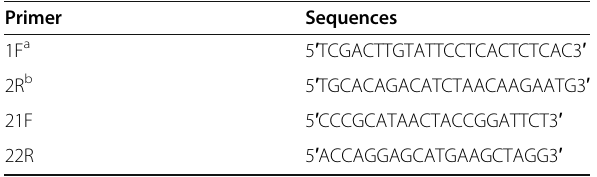
Table 1 Primers used for amplification of LprTFL